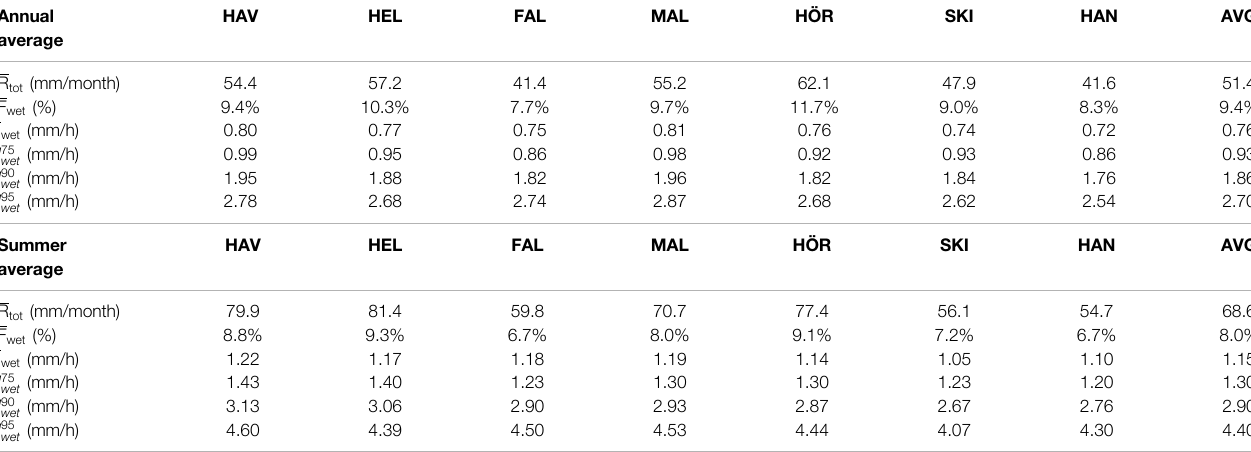
TABLE 2 | Annual and summer (June – August) averages of the intensity-based metrics for observed rainfall in each station and on average over all stations (AVG). Table 1 shows the periods of averaging. Annual HAV HEL FAL MAL HÖR SKI HAN average